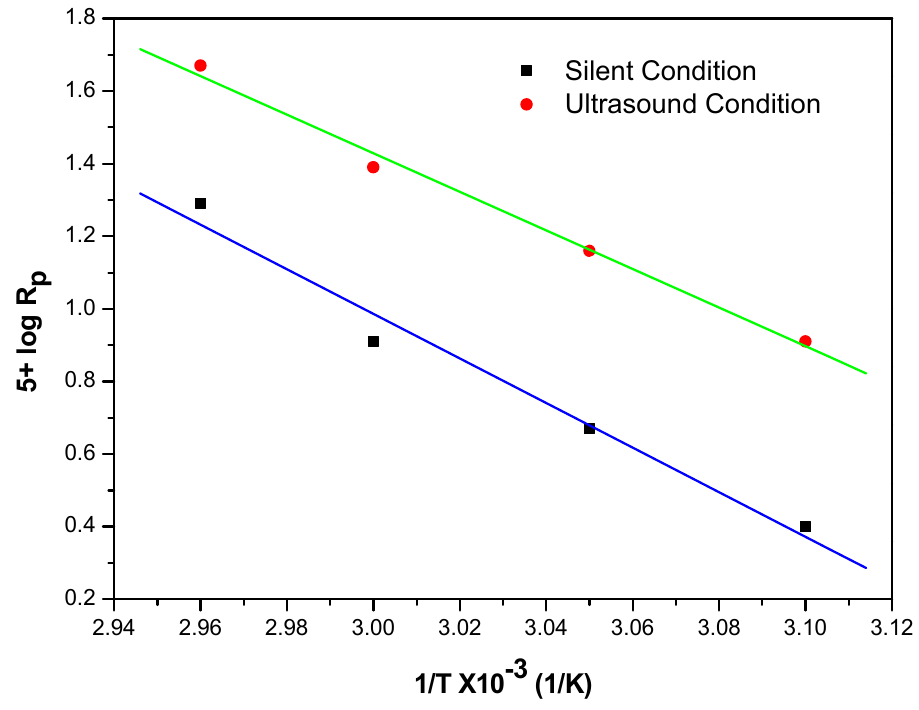
Figure 10. Arrhenius plot for the polymerization of MABE under the US-MPTC and Silent-MPTC conditions: 2.00 × 10 − 2 mol·dm − 3 of PPS, 1.2 × 10 − 2 mol·dm − 3 of BPMACB, 3.0 mol·dm − 3 of MABE, 0.3 mol·dm − 3 of [H + ], 0.1 mol·dm − 3 of [µ] (50 kHz, 300 W for ultrasonic assisted